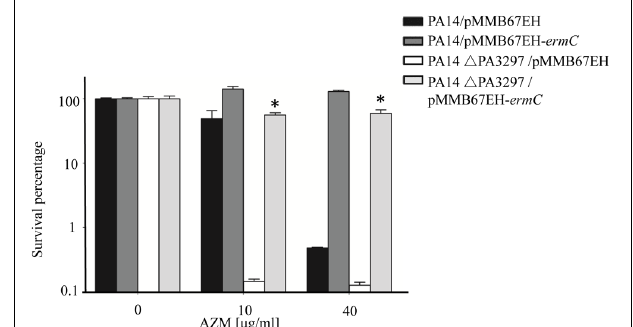
FIGURE 6 | Effects of Ribosome protection on the AZM mediated killing of the (cid:49) PA3297 mutant. Wild type PA14 or the (cid:49) PA3297 mutant harboring pMMB67EH or pMMB67EH- ermC was grown to an OD 600 of 0.5 when 1 mM IPTG was added to the medium. When the OD 600 reached 2.0, the bacteria were treated without or with 10 or 40 µ g/ml AZM for 20 h at 37 ◦ C. The numbers of live bacteria were determined by serial dilution and plating. ∗ p < 0.05 compared to the (cid:49) PA3297 mutant harboring pMMB67EH by student’s t -test.